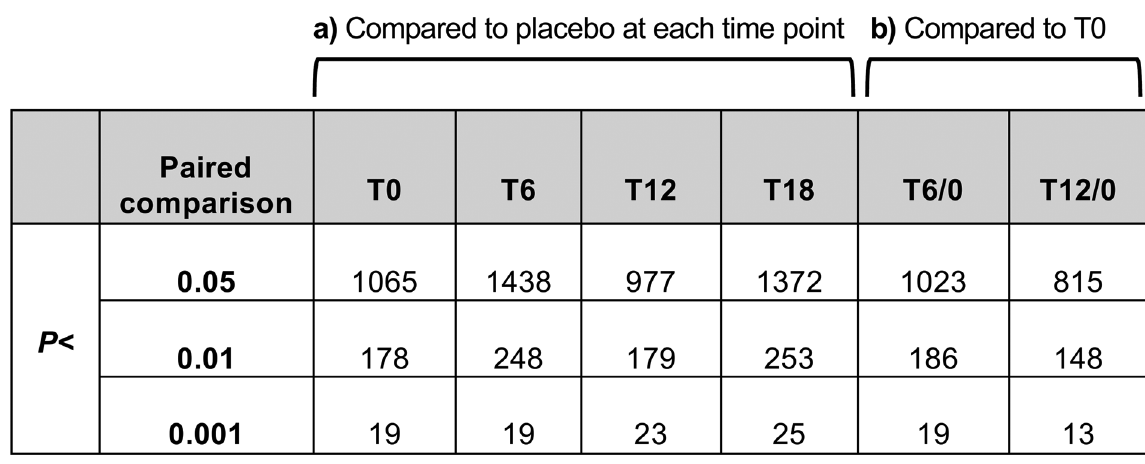
Figure 4. Atorvastatin treatment effect on monocyte gene expression: Pairwise comparisons were made between (a) individual time points (weeks 0, 6,12, and 18) in atorvastatin versus placebo group and, (b) week 6 and week 12 versus week 0 within Atorvastatin group. Table shows number of monocyte genes affected at 3 different P value thresholds ( P <0.001, 0.01, and 0.05). Only nominal P values were used since the minimum FDR value was FDR=74% across all